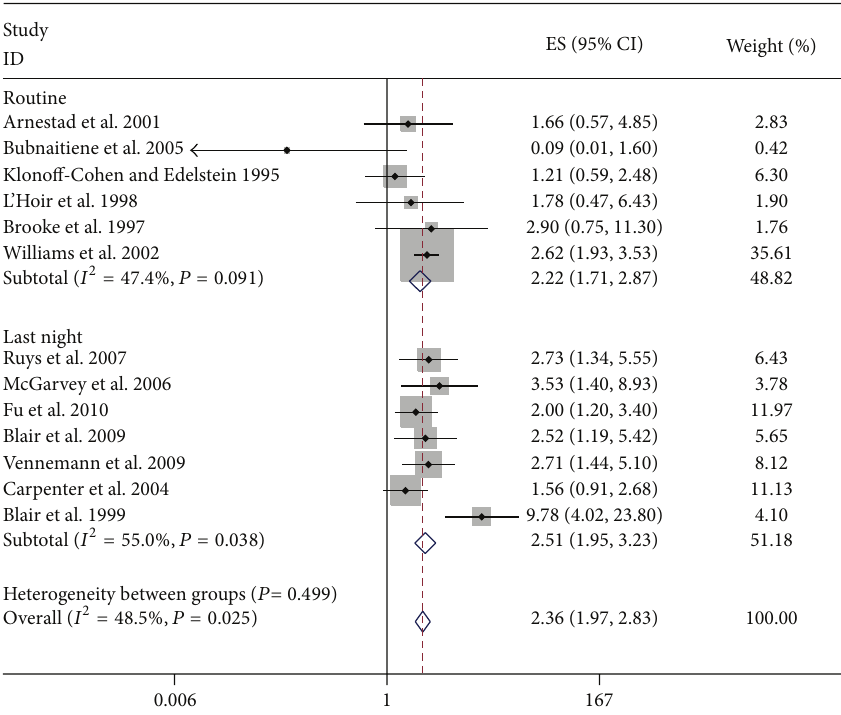
Figure 3: Forest plot: bed share and